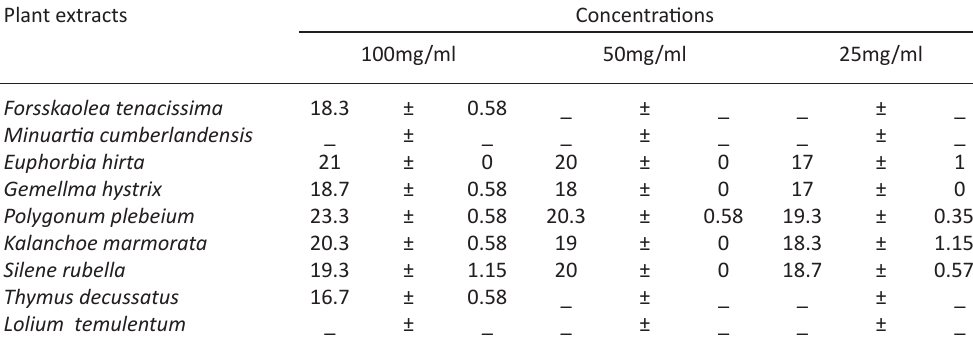
Table 1. Effect of nine different plant extracts on MRSA, B39 Plant extracts Concentrations